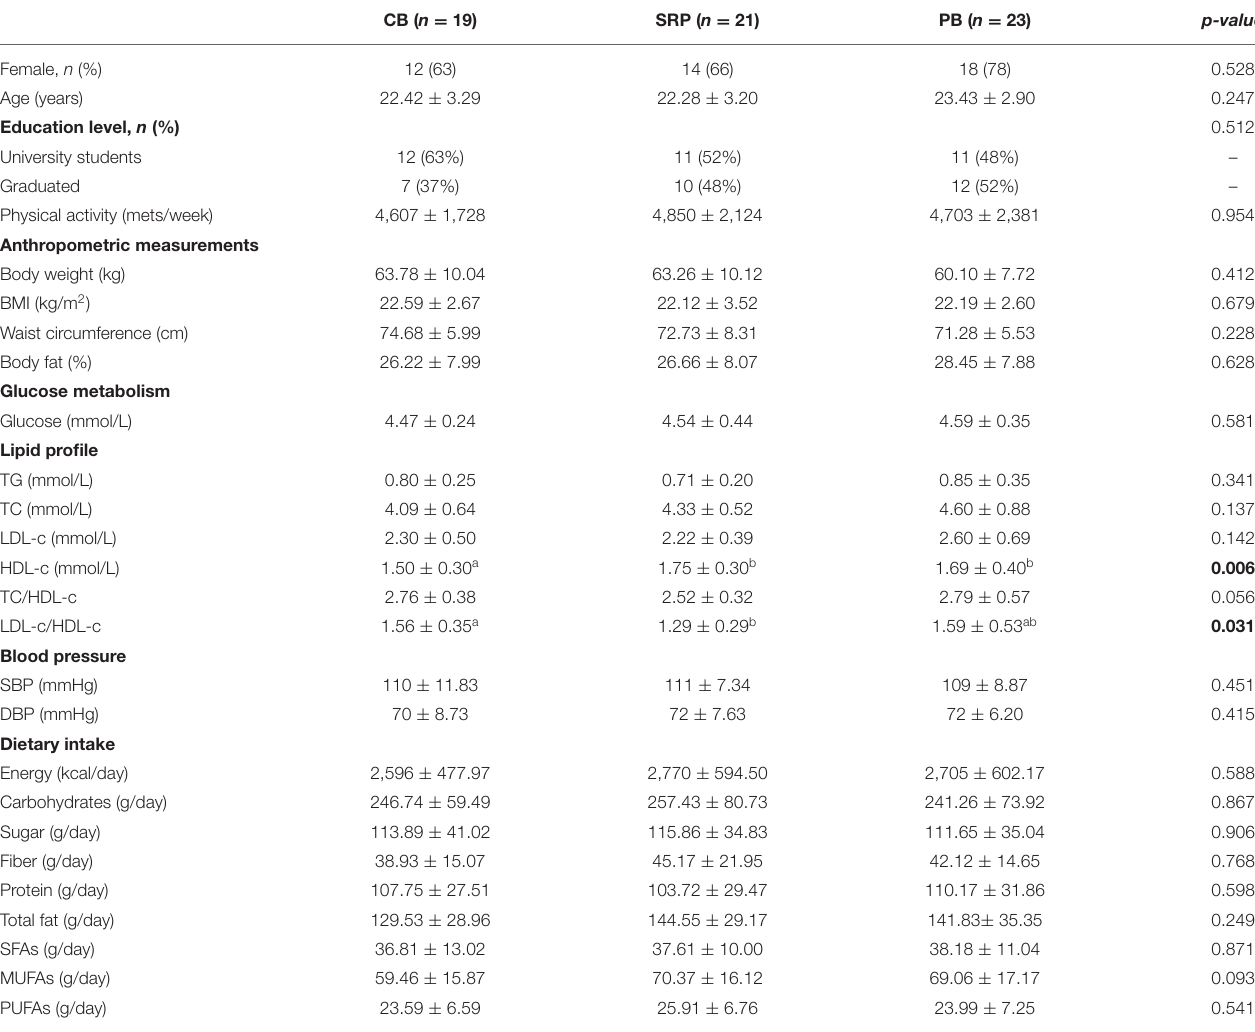
TABLE 1 | Participant characteristics at